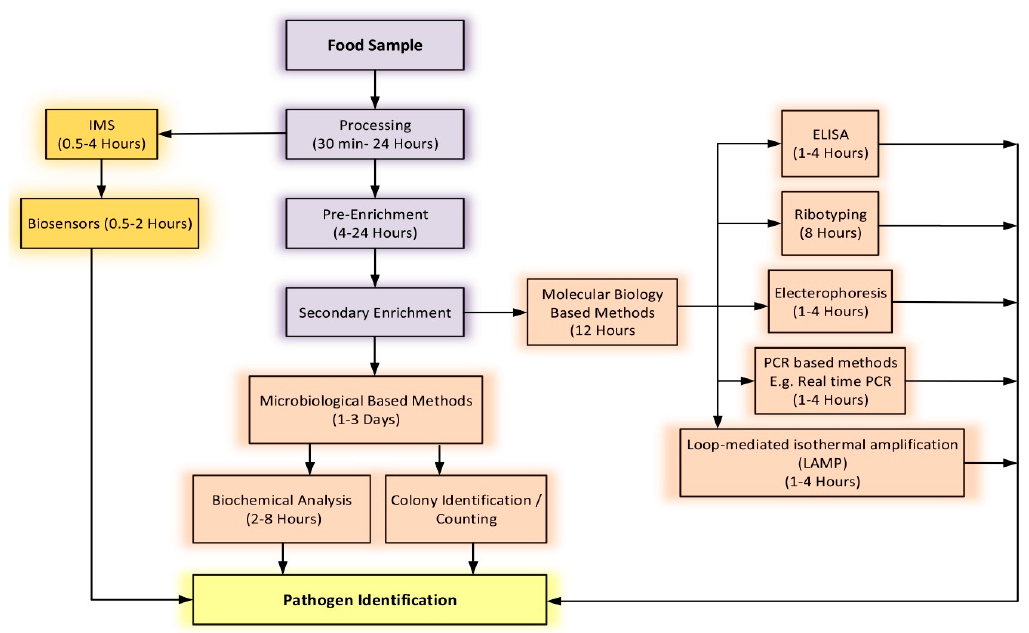
Figure 1. The steps involved in the diagnosis and analysis of food samples using common techniques and the time it takes to detect the pathogen.